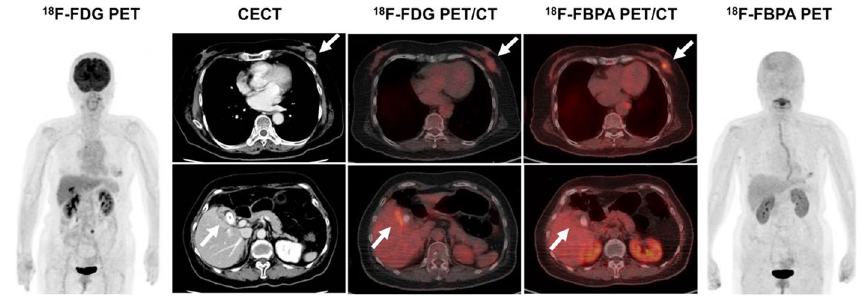
Fig. 5 An 80-year-old woman underwent contrast-enhanced CT (CECT) for a recently diagnosed breast tumor before surgery. CECT revealed gallbladder wall thickening with gallstones and a contrast enhancement effect, in addition to a left mammary mass, which may indicate gallbladder cancer. 18 F-FDG PET/CT showed a local increase in accumulation in the gallbladder wall (SUVmax: 8.1), making it difficult to differentiate gallbladder cancer from cholecystitis. 18 F-FBPA PET/CT showed accumulation in the left breast